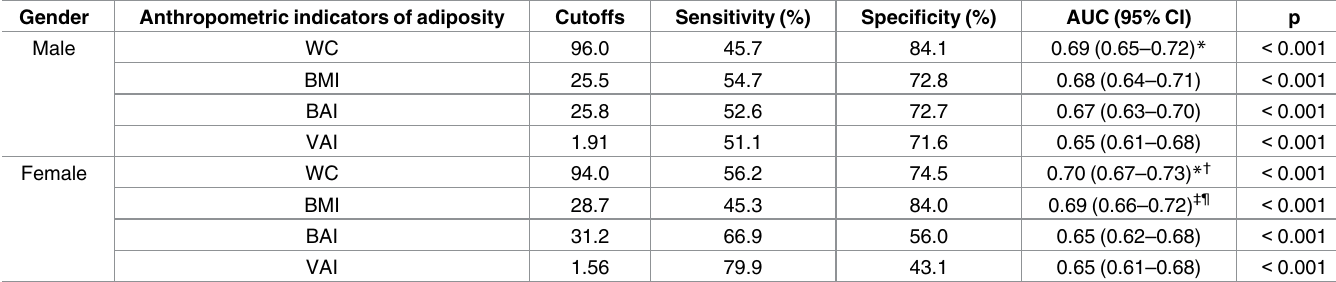
Table 2. Determination of the optimal cutoffs values and AUC for WC, BMI, BAI and VAI in a Brazilian population. Gender Anthropometric indicators of